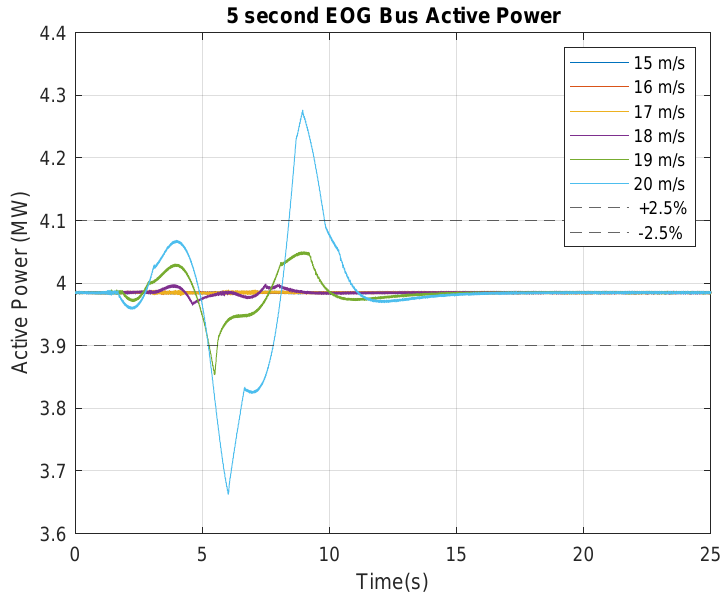
Figure 16. EOG Bus Active Power Responses ∆ T = 5 s. All test runs are displayed in Table 5. The light blue denotes the output remains within the respective boundary condition with dark blue showing that one or both of the ± 2.5% boundaries have been